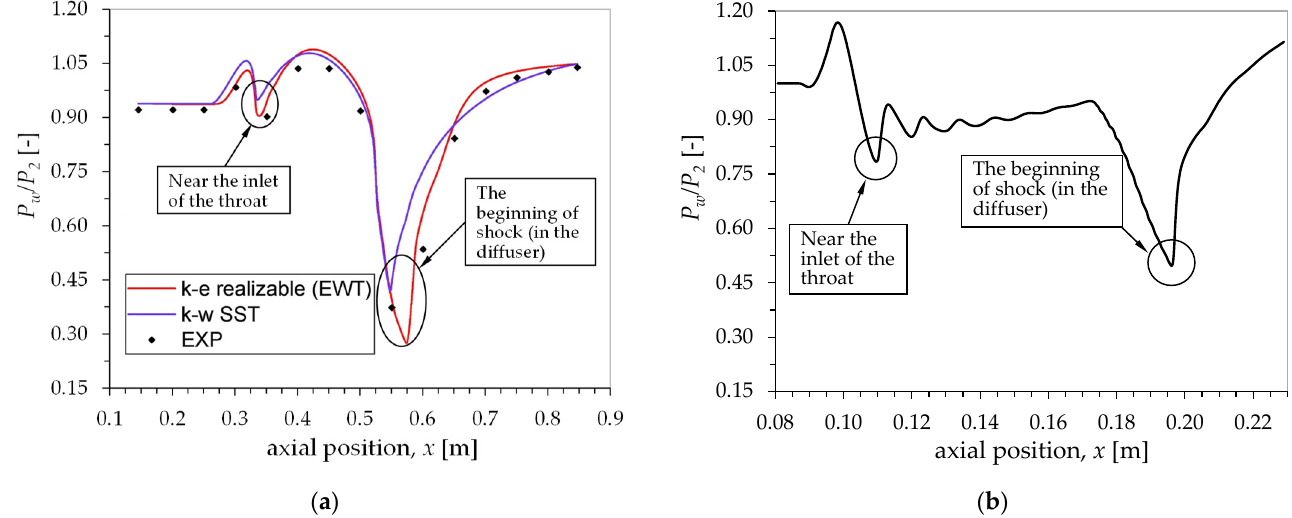
Figure 8. Qualitative comparison of the non-dimensional wall pressure ( P w / P 2 ) along the mixing section up to the diffuser between Han et al.’s work ( a ) and the current work (turbulence model: transition SST; P 0 = 618 kPa) ( b ). The left figure ( a ) is reprinted from the work of Han et al. [25] with the wall pressure ( y -axis) is non-dimensionalized by the secondary inlet pressure of their work ( P 2 = 3170